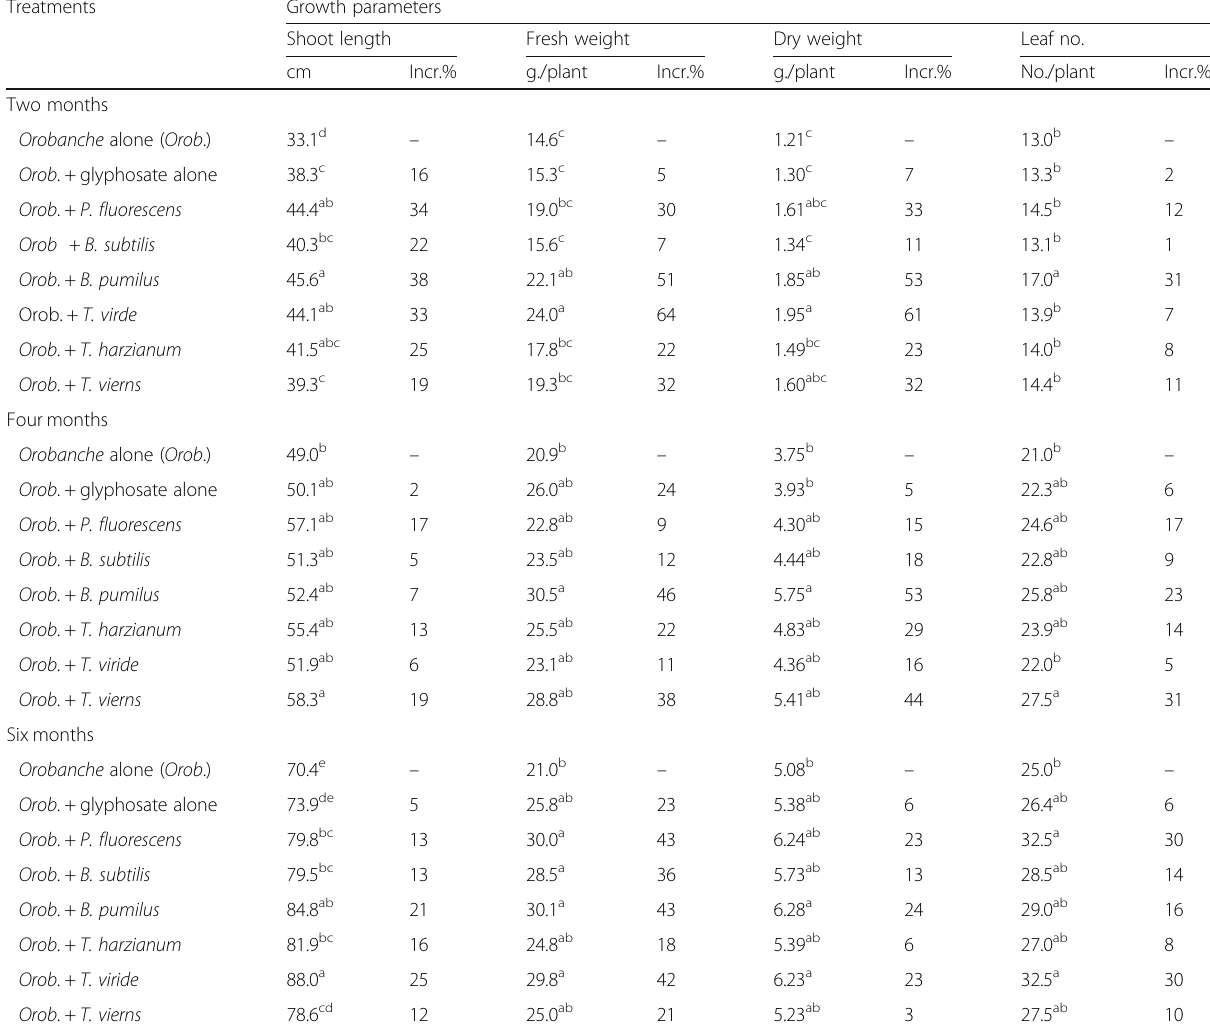
Table 5 Effects of plant growth-promoting bacteria and Trichoderma species on growth parameters of faba bean with O. crenata infection, under greenhouse conditions (Experiment III)